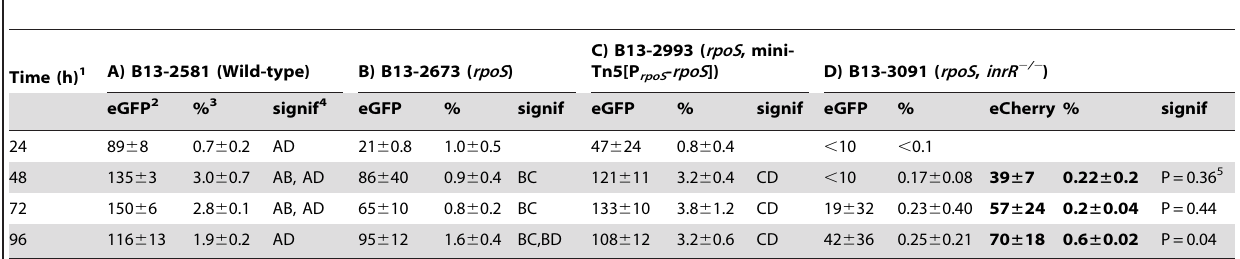
Table 2. Effect of rpoS inactivation on reporter fluorescence from a single-copy P int - egfp ; P inR - eCherry fusion in P. knackmussii strain B13 and derivatives.